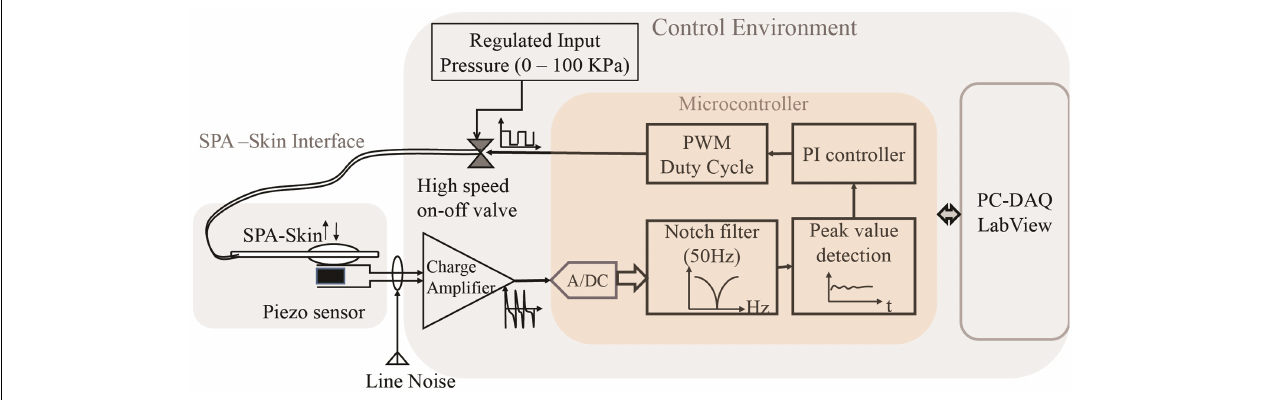
FIGURE 5 | Block diagram for SPA skin interfaced with the control environment for a single sensor and actuator . The SPA skin interface receives pneumatic input and produces piezo electric output. The control environment performs signal acquisition, amplification, conditioning, control, and output actuation tasks from the raw PZT signal. Microcontroller-based signal processing reduces the circuit area required for multiple sensors, as only a new charge amplifier is added per sensor. The long connecting electrodes from PZT sensor capture external line noise, which gets amplified through charge amplifier